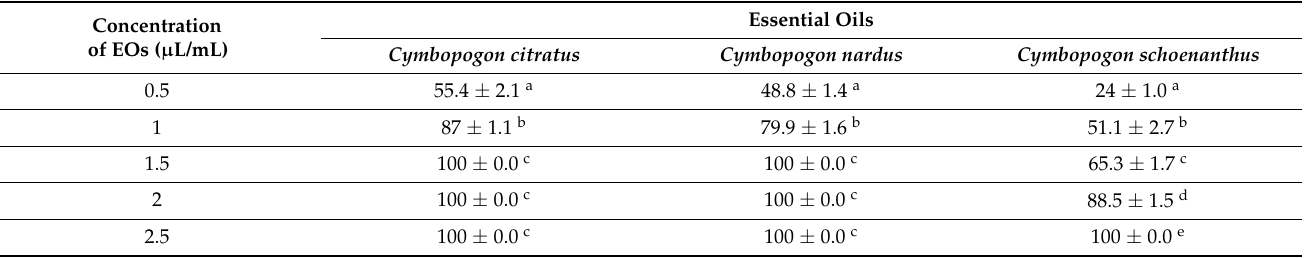
Table 3. Inhibition of mycelial growth of Aspergillus flavus (%), depending on the concentration of the essential oil.